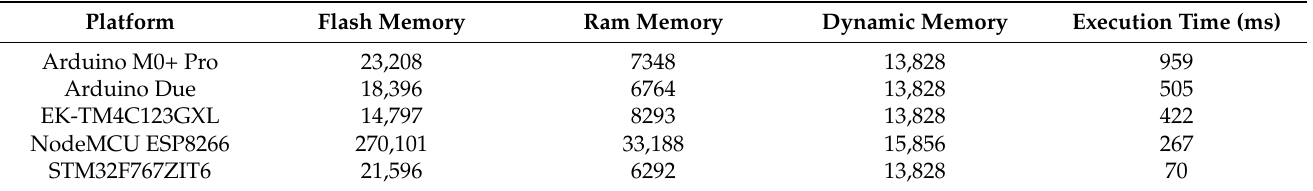
Table 2. Profiling results for 32 samples 0-Dimensional Homology Analysis. The memory is in bytes. The Dynamic Memory field represents the maximum amount of memory used by an iteration. The table is ordered by execution time.